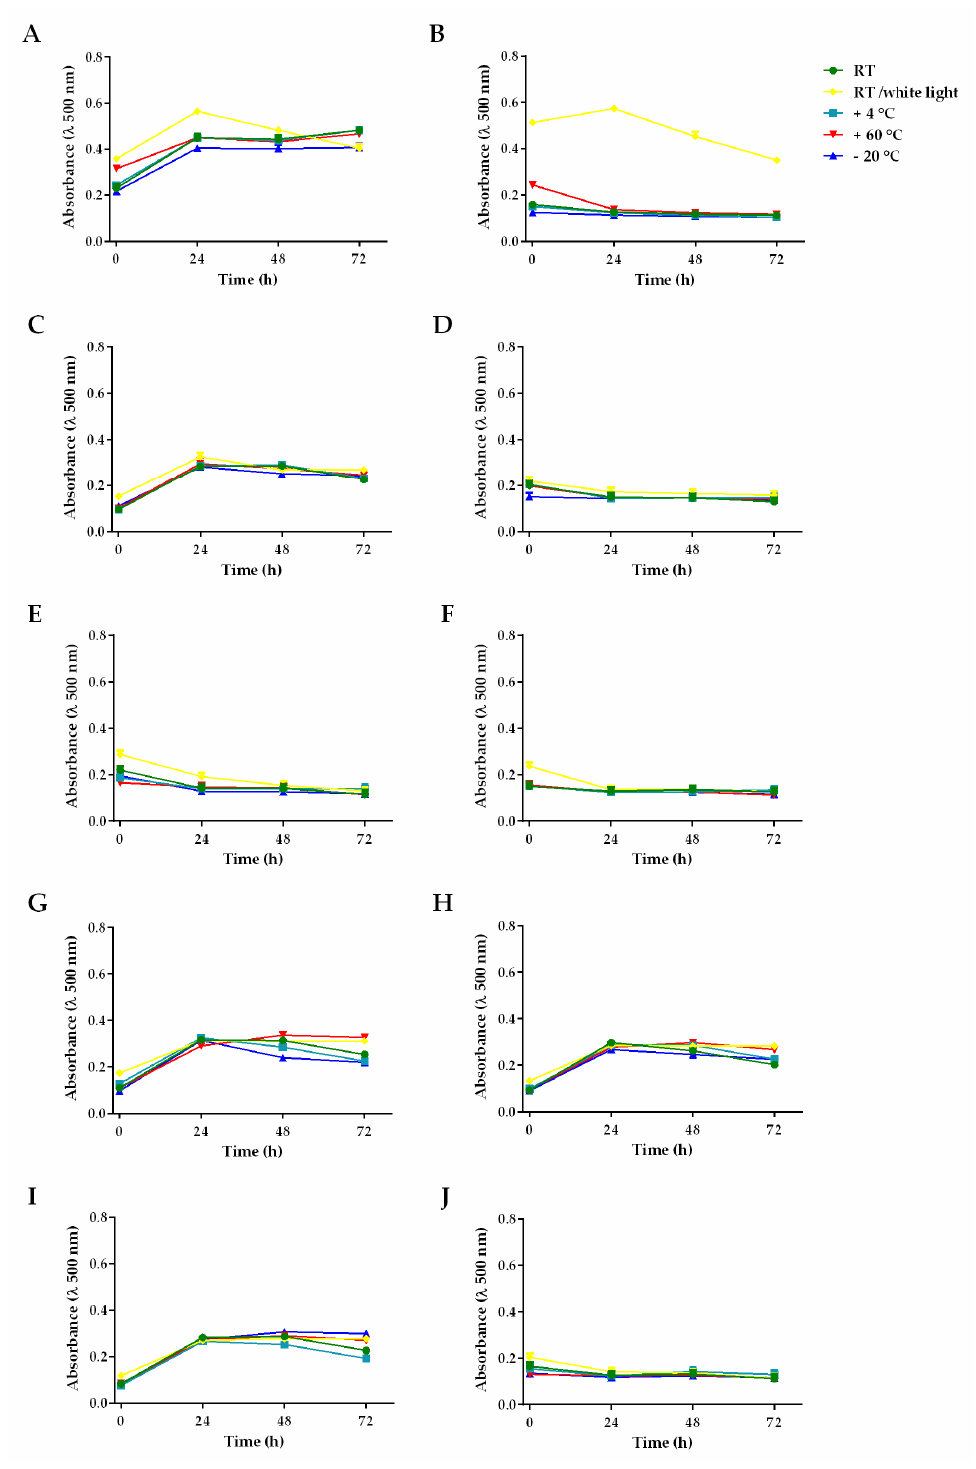
Figure 4. Absorbance (λ 500 nm) of lipoperoxides produced in different hemp seed oils, with respect to linoleic acid ( A ) under multiple storage conditions and incubation times (t = 0, 24, 48, and 72 h). Hemp seed oils: ( B ) 1, ( C ) 2, ( D ) 3, ( E ) 4, ( F ) 5, ( G ) 6, ( H ) 7, ( I ) 8, ( J )